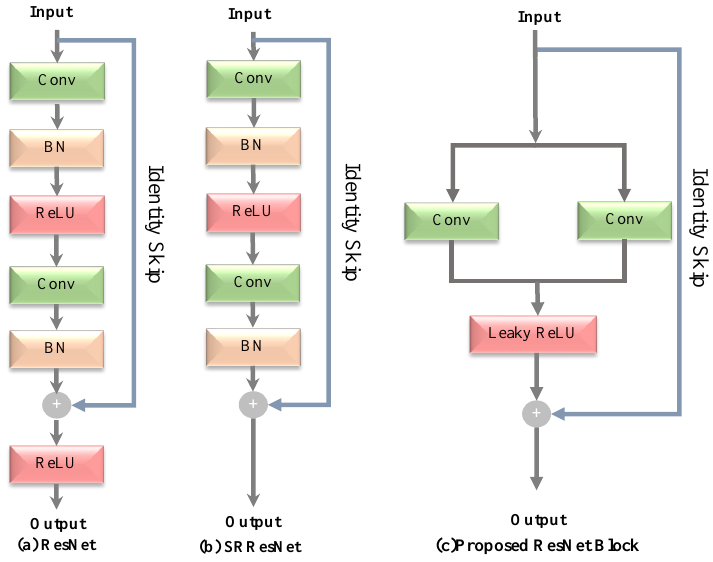
Figure 2. The comparison of residual blocks in ResNet, SRResNet, and our proposed